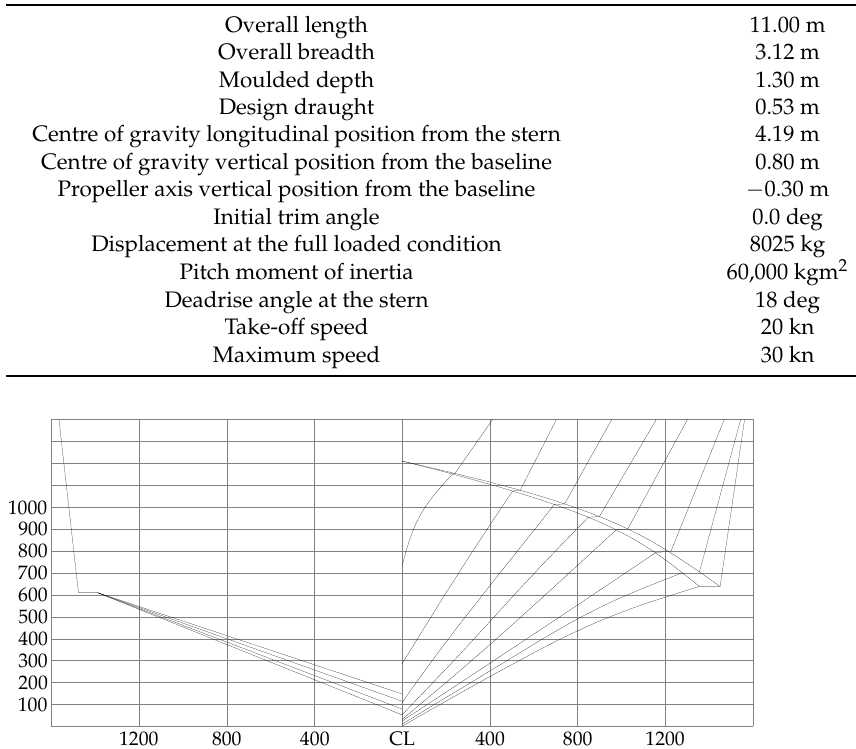
Table 1. Main properties of reference craft.